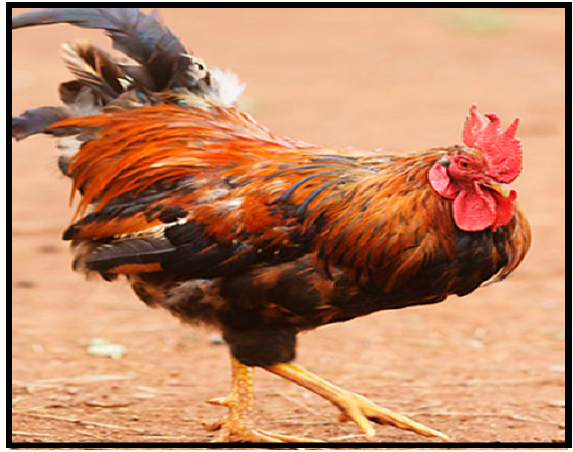
Figure 3. Ovambo chicken breed. Source: [4].